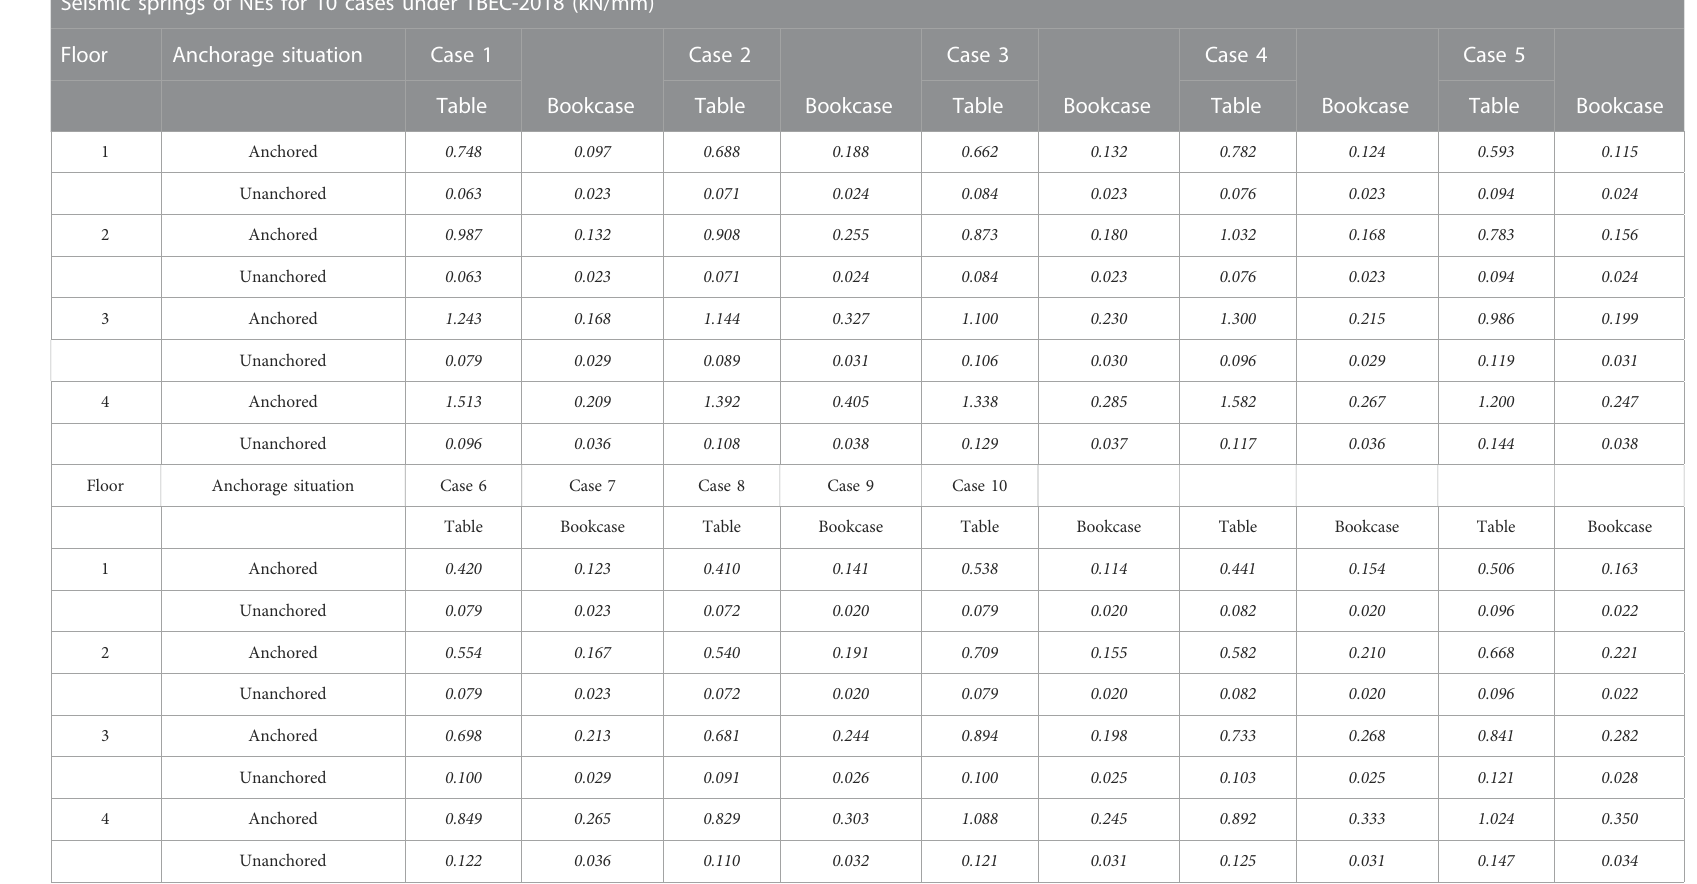
TABLE 11 Calculated seismic stiffness parameters of NEs for 10 different cases under TBEC-2018 (Cavuslu, 2022). Seismic springs of NEs for 10 cases under TBEC-2018 (kN/mm) Floor